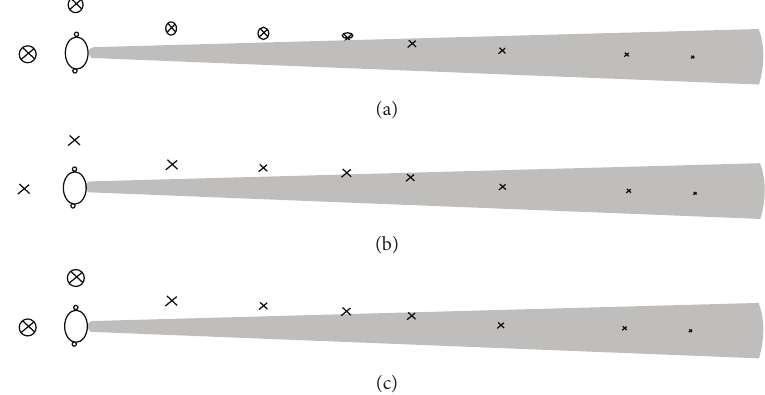
Figure 6: Illustration of a person with tunnel vision in a traffic situation. The shaded area shows the visual field of the P. Objects marked with a cross and ring are not detected while objects marked with a cross are detected. (a) Without Monitor (noM). (b) With Monitor with omnidirectional microphone (MO). (c) With Monitor with directional microphone